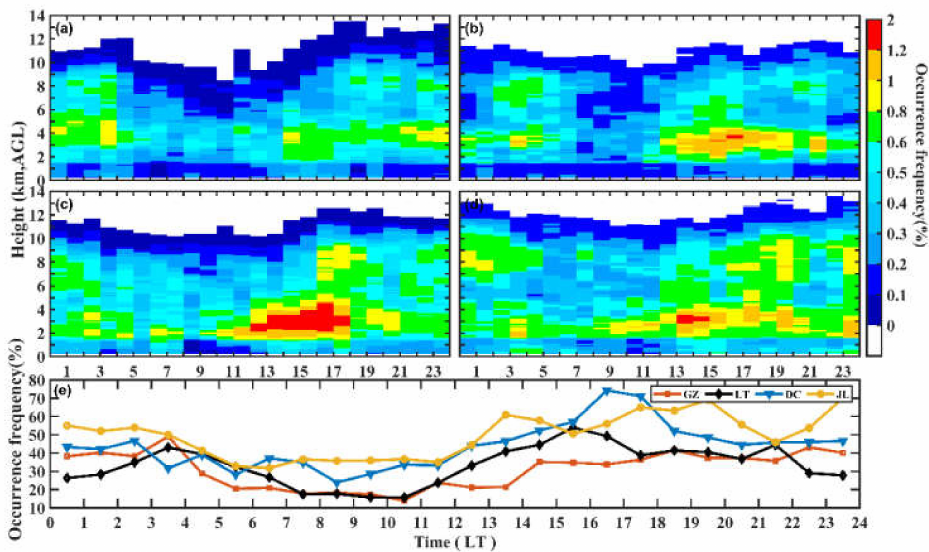
Figure 4. Diurnal variations of cloud occurrence frequency at four sites. ( a ) GZ; ( b ) LT; ( c ) DC; ( d ) JL; ( e ) hourly changes of cloud occurrence